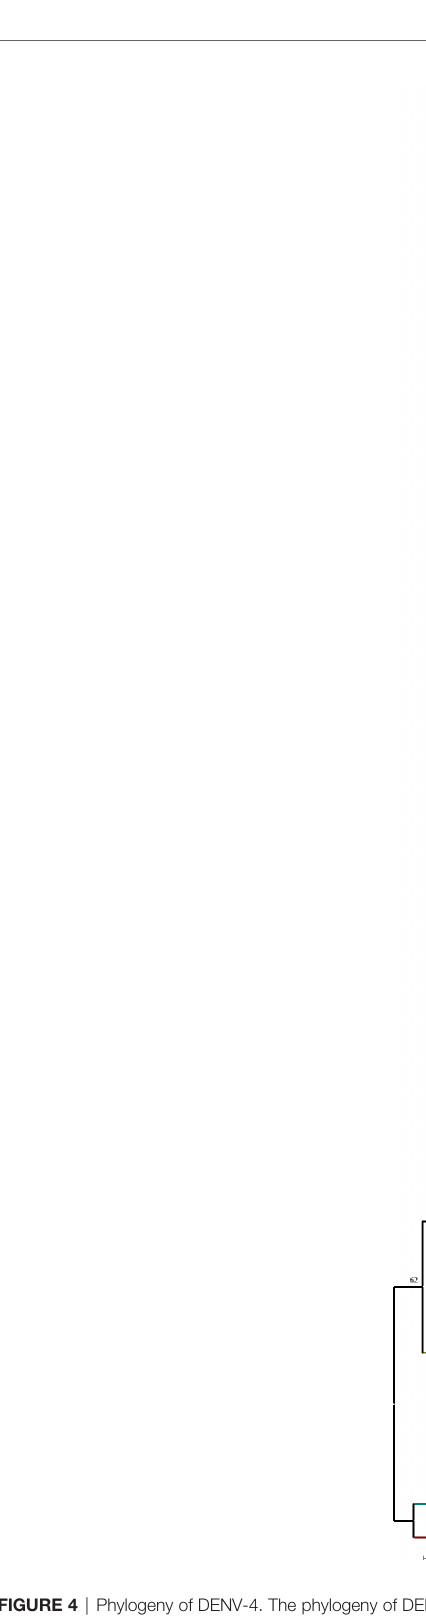
Frontiers in Cellular and Infection Microbiology |